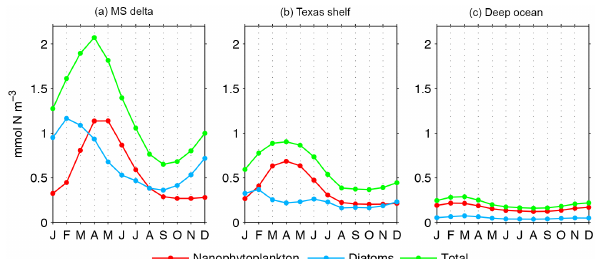
Figure 9. Climatological seasonal cycle of phytoplankton biomass in the 30m upper layer from the Mississippi delta, Texas shelf, and deep ocean (regions depicted in Fig. 1, gray